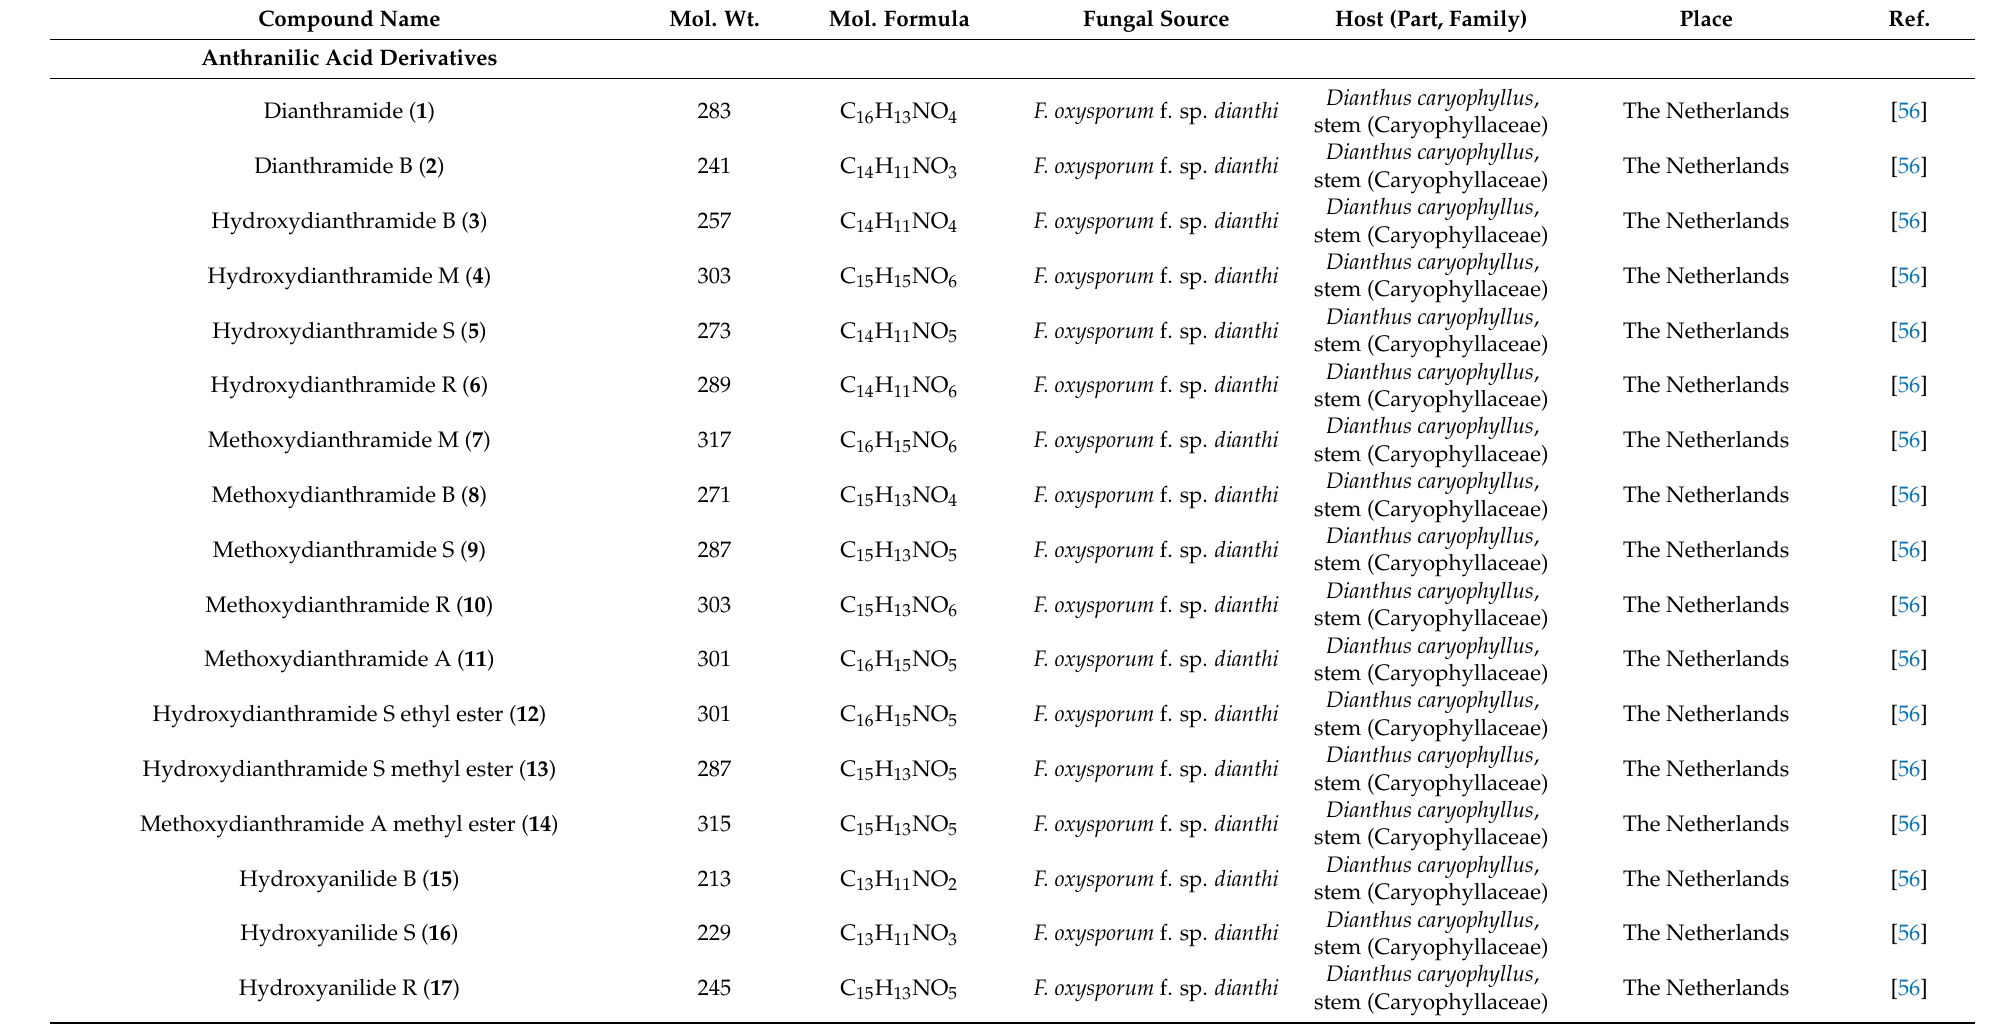
Table 1. List of compounds isolated from F. oxysporum (chemical class, molecular weight and formulae, fungal source, host, and